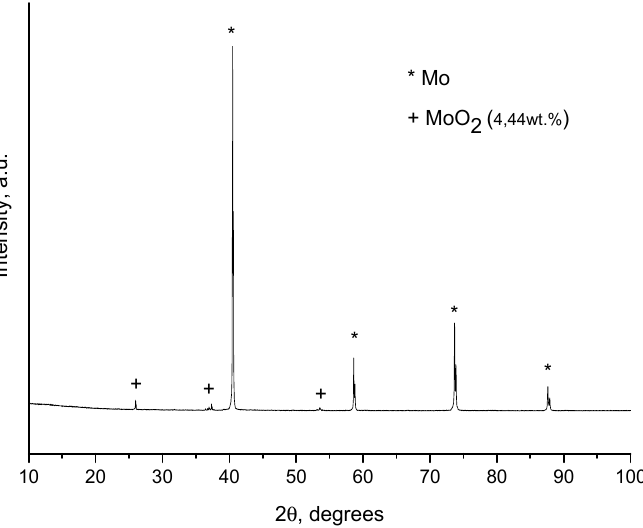
Figure 4. XRD pattern of the starting Mo powder.